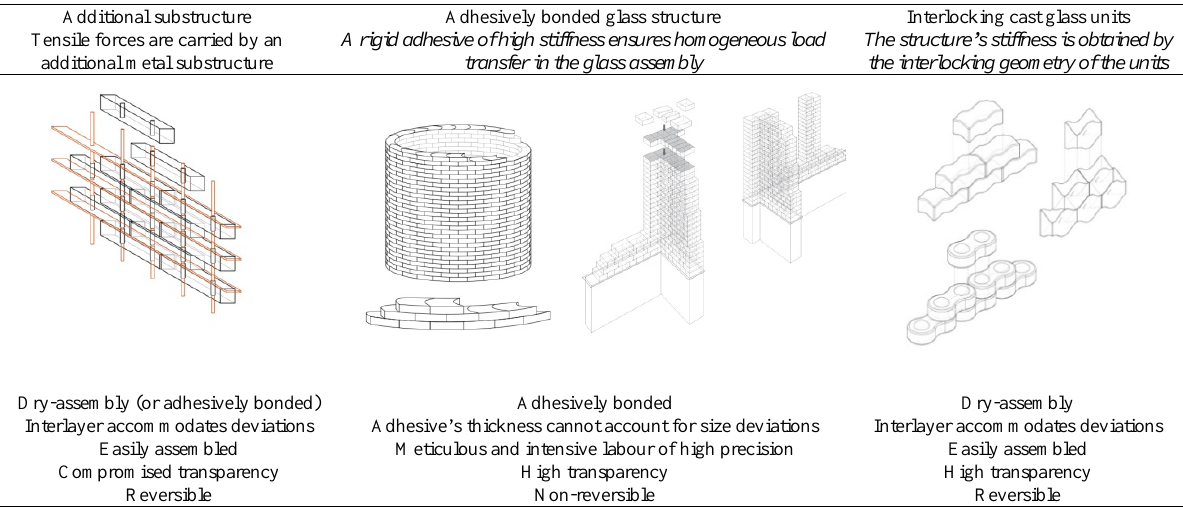
Table 1: Design concepts for self-supporting envelopes out of cast glass